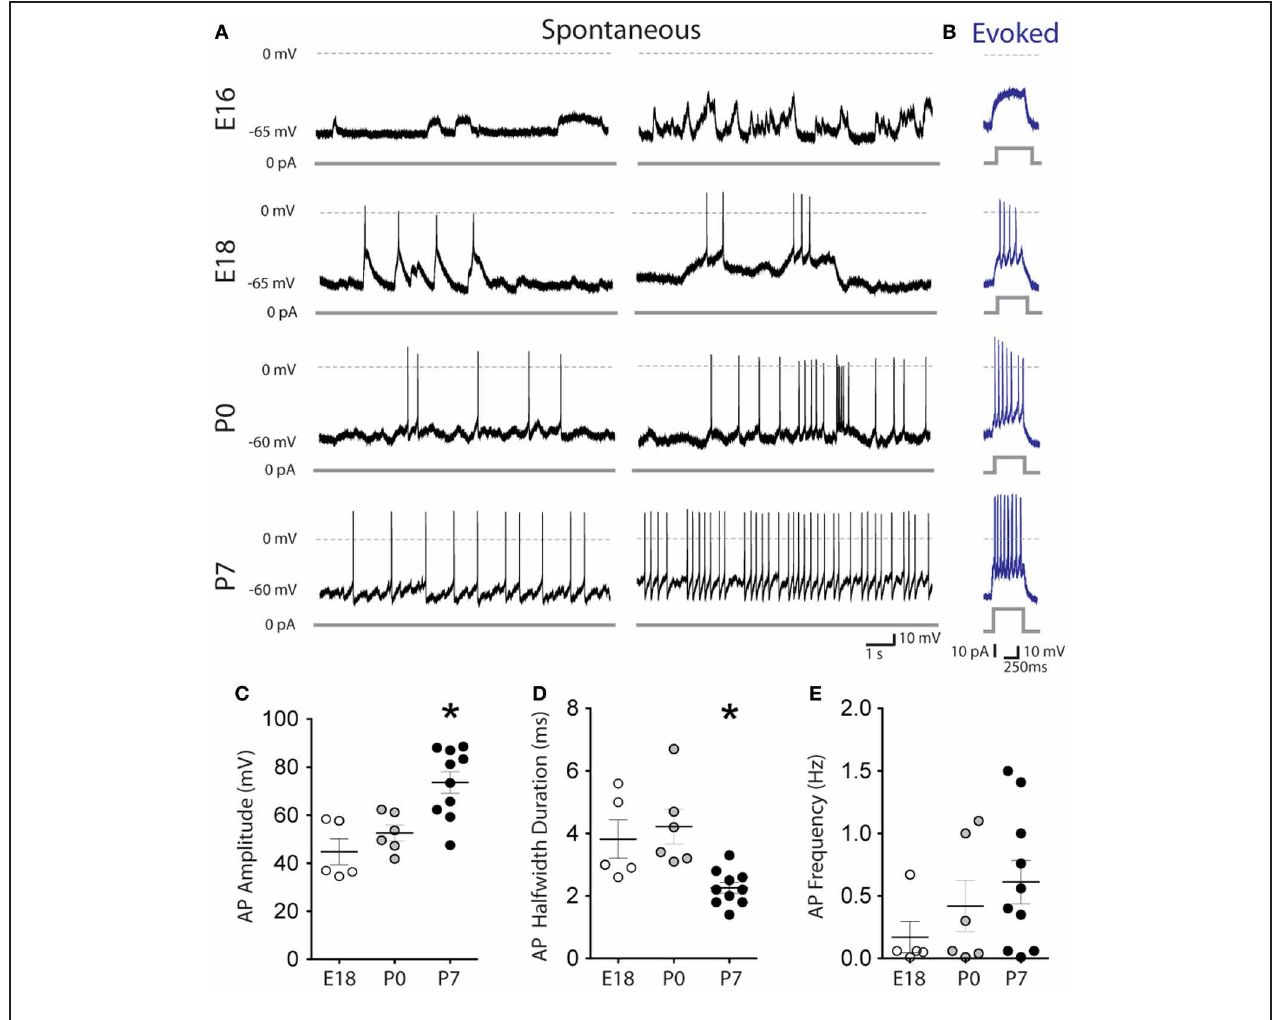
FIGURE 4 | Firing patterns of embryonic and early postnatal mDA neurons. Spontaneous (A) and evoked (B) membrane potential changes recorded in whole-cell configuration, current clamp mode from midbrain